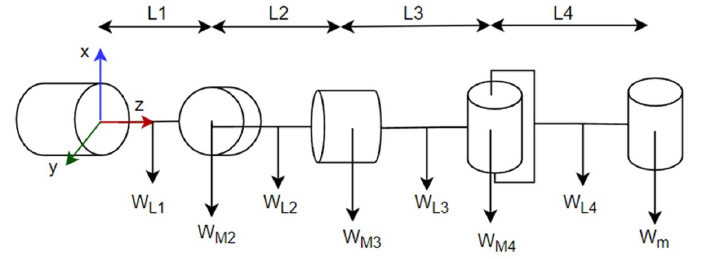
Figure 3. Free-body diagram of a horizontally extended arm.